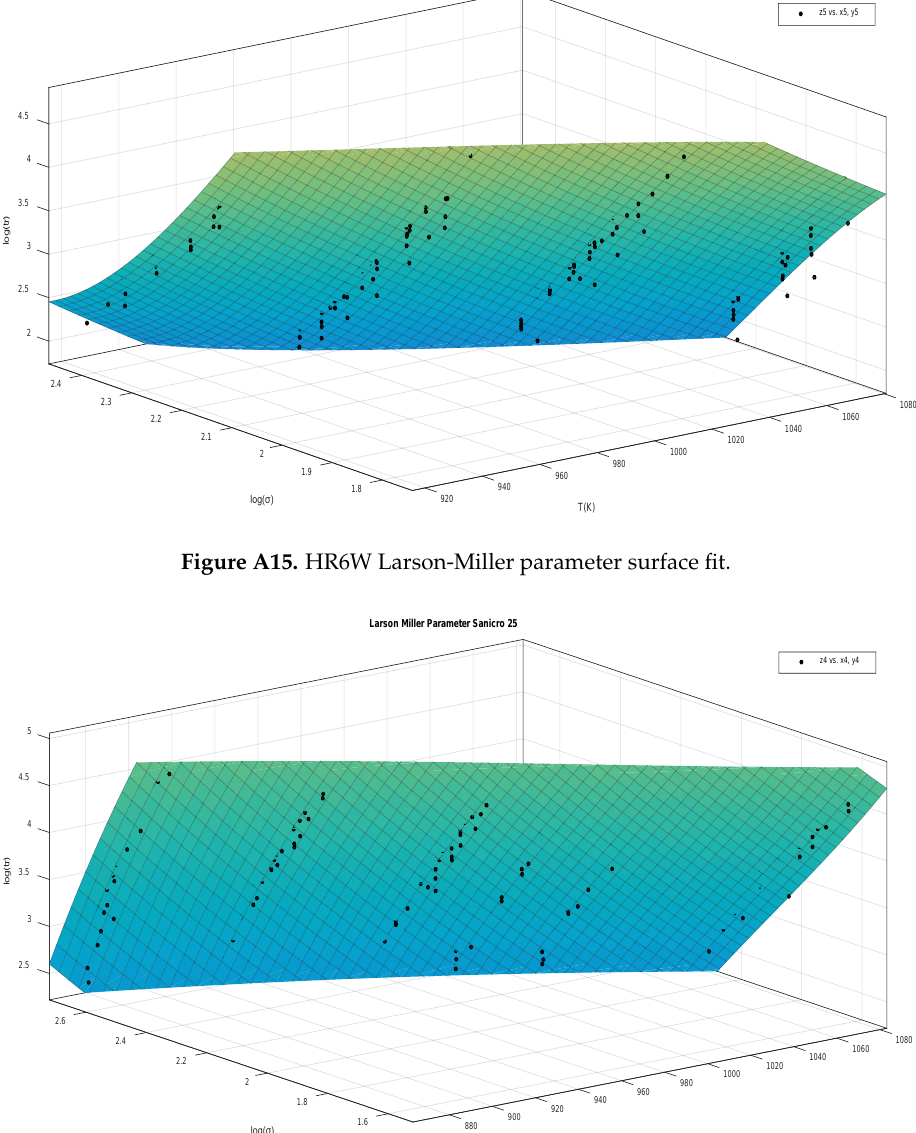
Figure A16. Sanicro 25 Larson-Miller parameter surface fit.